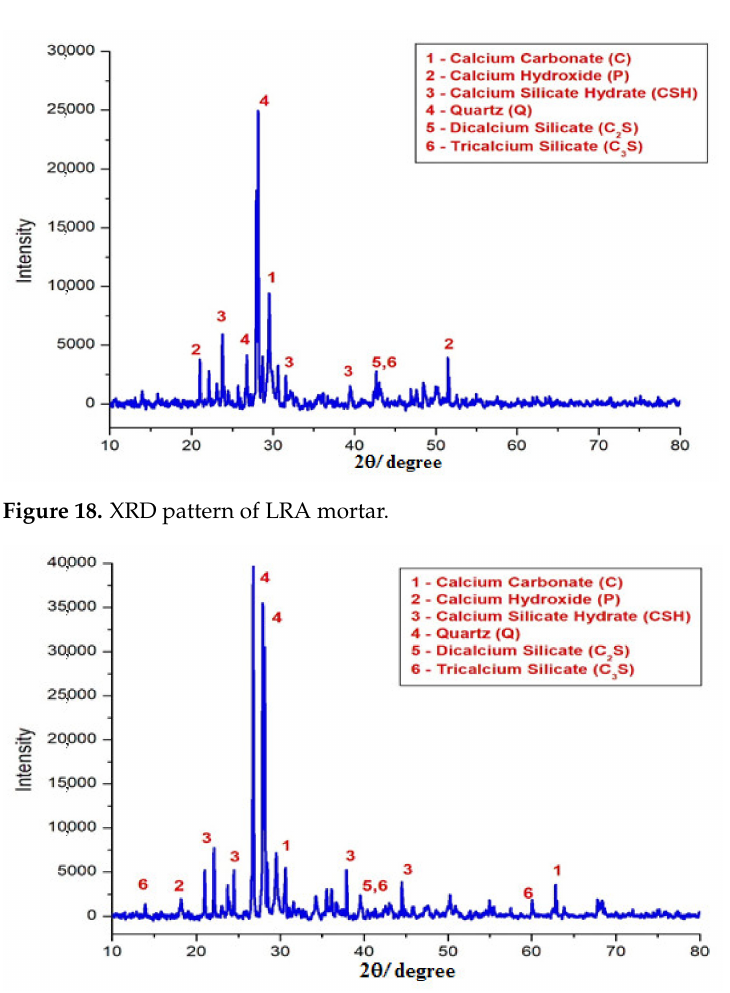
Figure 19. XRD pattern of LSR